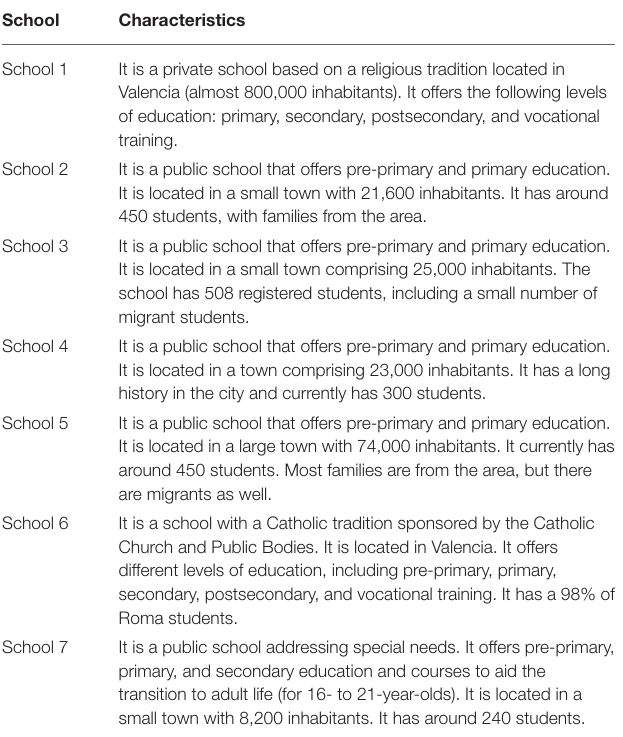
TABLE 1 | Characteristics of the schools included in the present